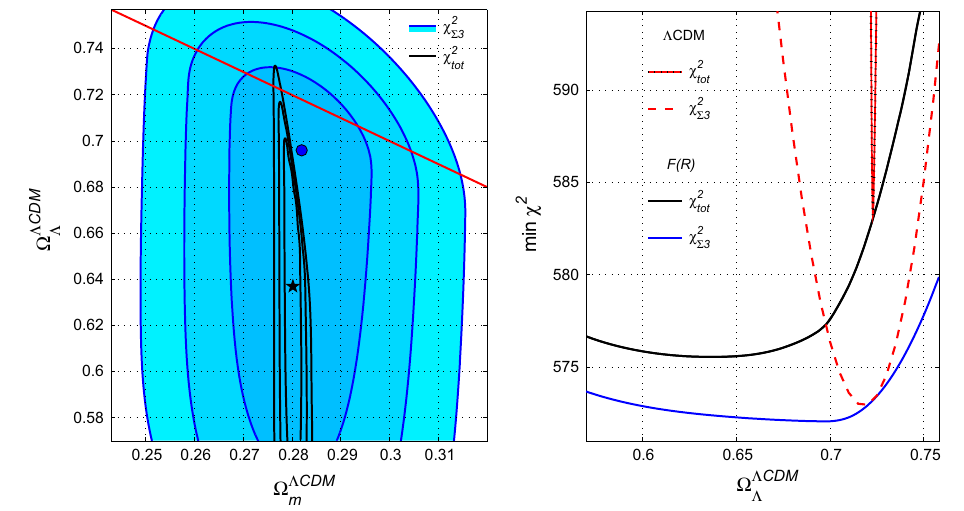
χ 2 (cid:17) 3 tot (solid black lines) and for